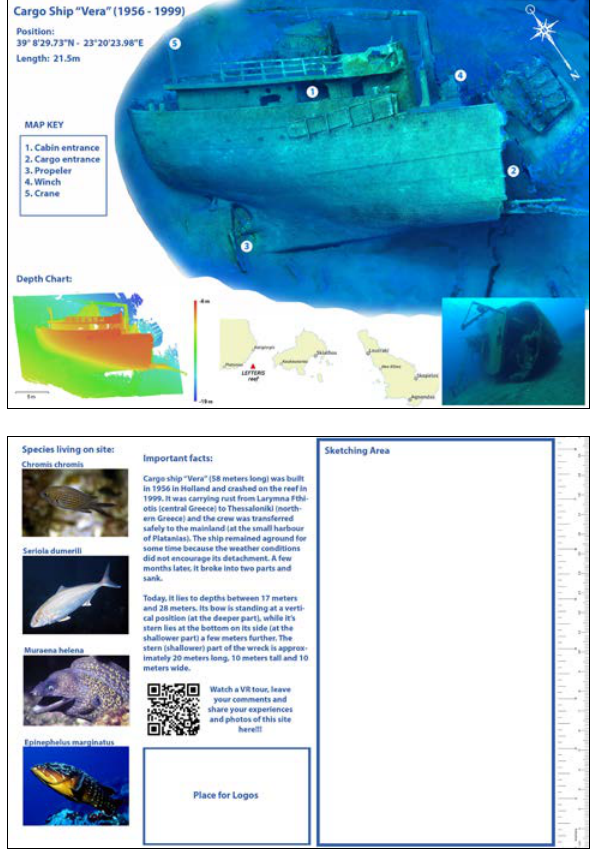
Figure 7. The front and rear sides of the wreck diving